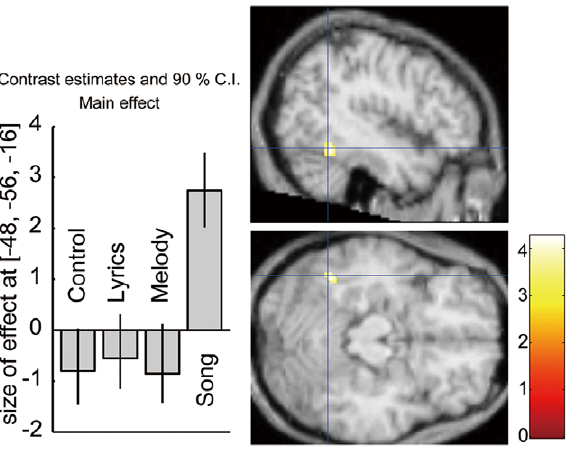
Figure 5. The region specifically activated by Song (Song–C > Song–Lyrics > Song–Melody). Number of color bar represents z - value. The plots represent the relative intensities in this region of interest under the different conditions. Error bars represent the